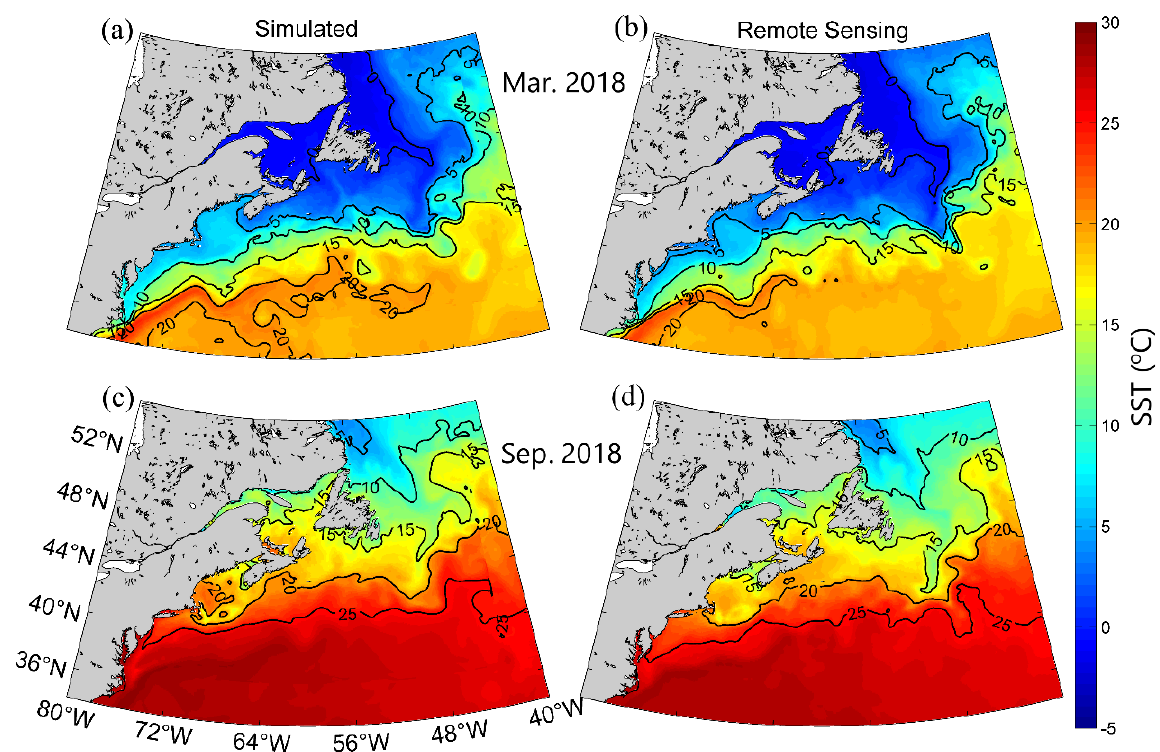
Figure 5. Monthly-mean sea surface temperature (SST) over the submodel L1 domain in ( a , b ) March and ( c , d ) September 2018 from ( a , c ) the results of submodel L1 and ( b , d ) satellite remote sensing SST data.